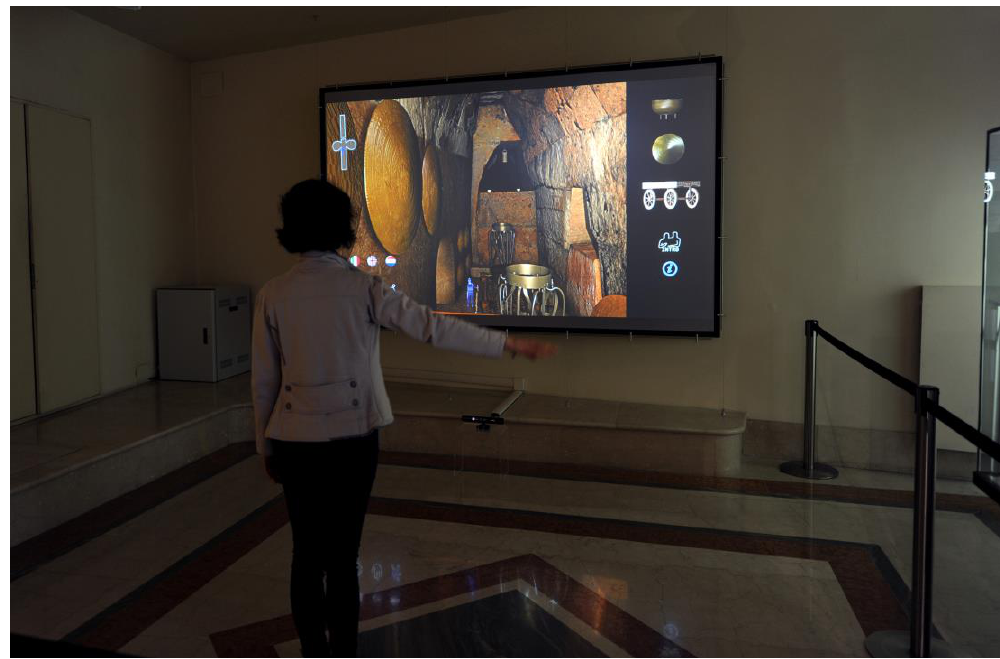
Figure 5. Room in the Vatican Museums dedicated to the virtual exploration of the Regolini Galassi Tomb. Permanent VR installation with gesture based interaction, realized in 2013 by CNR ITABC in collaboration with the Vatican Museums in the EU Etruscanning project framework. In this case the application can be explored after the visit of the room hosting the real objects of the funerary good. The visitor can recognize them in the virtual reconstruction, digitally restored.